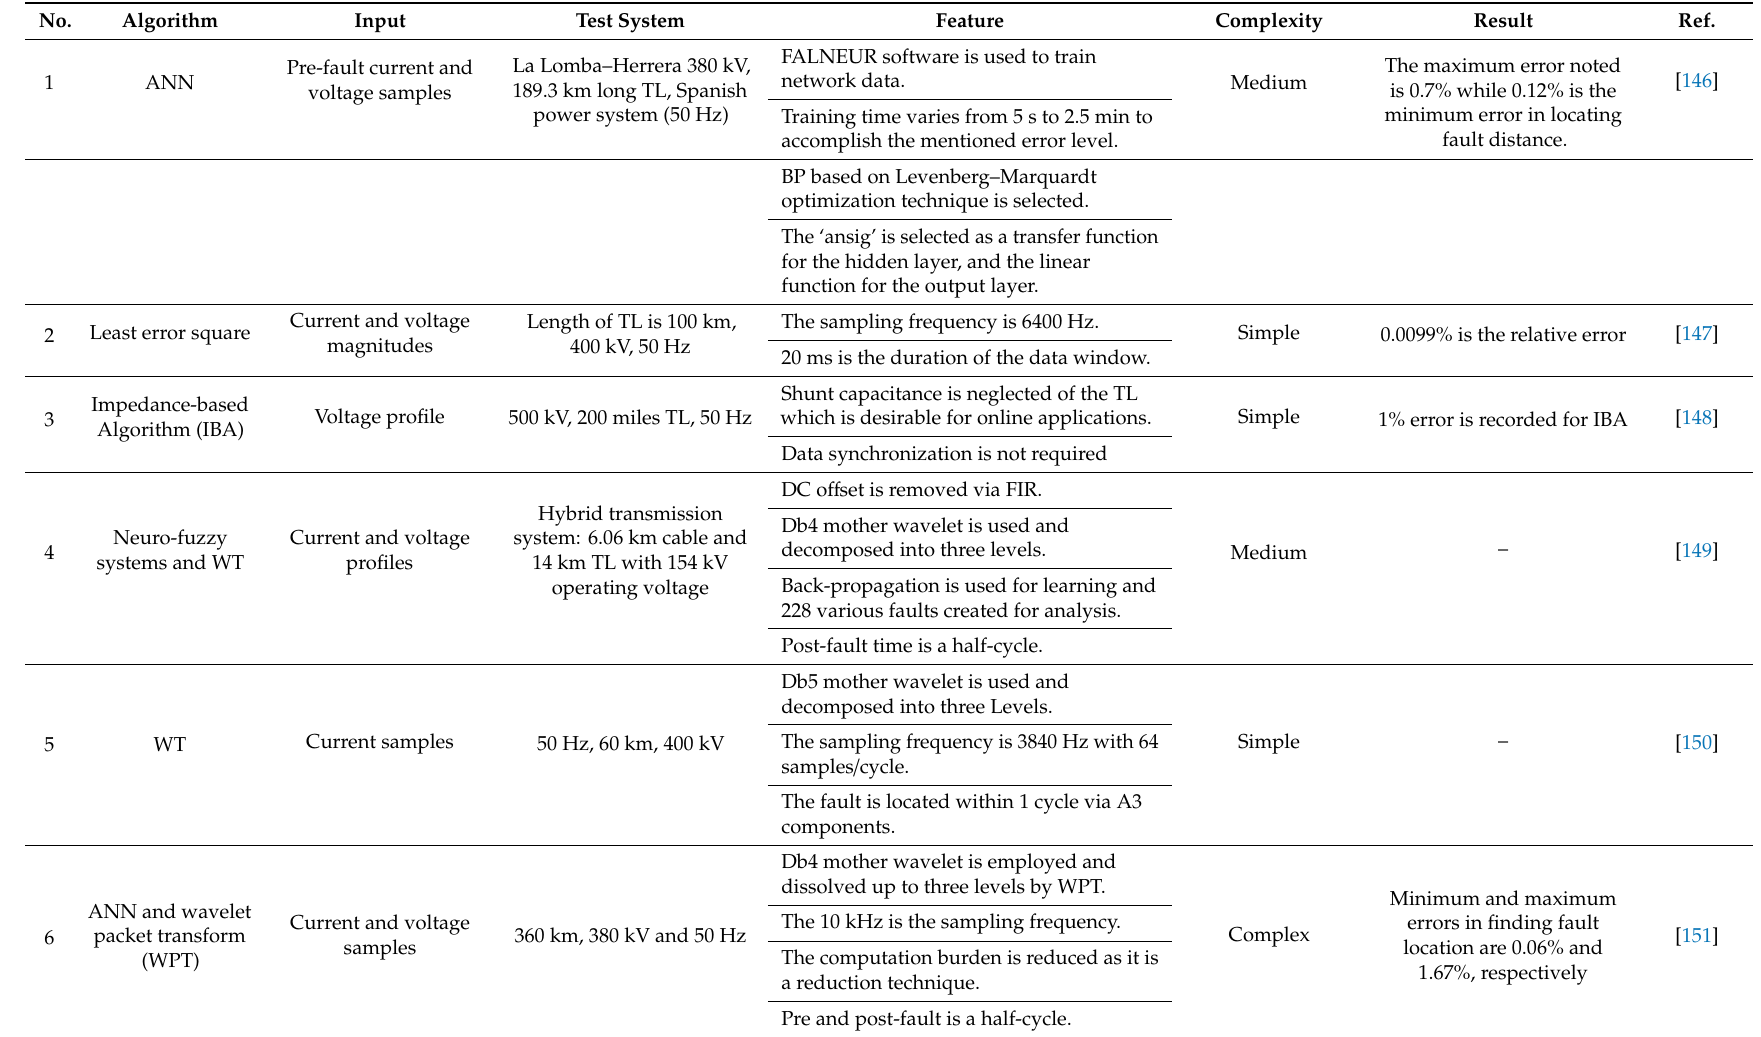
Table 3. Comparison of di ff erent fault location finding